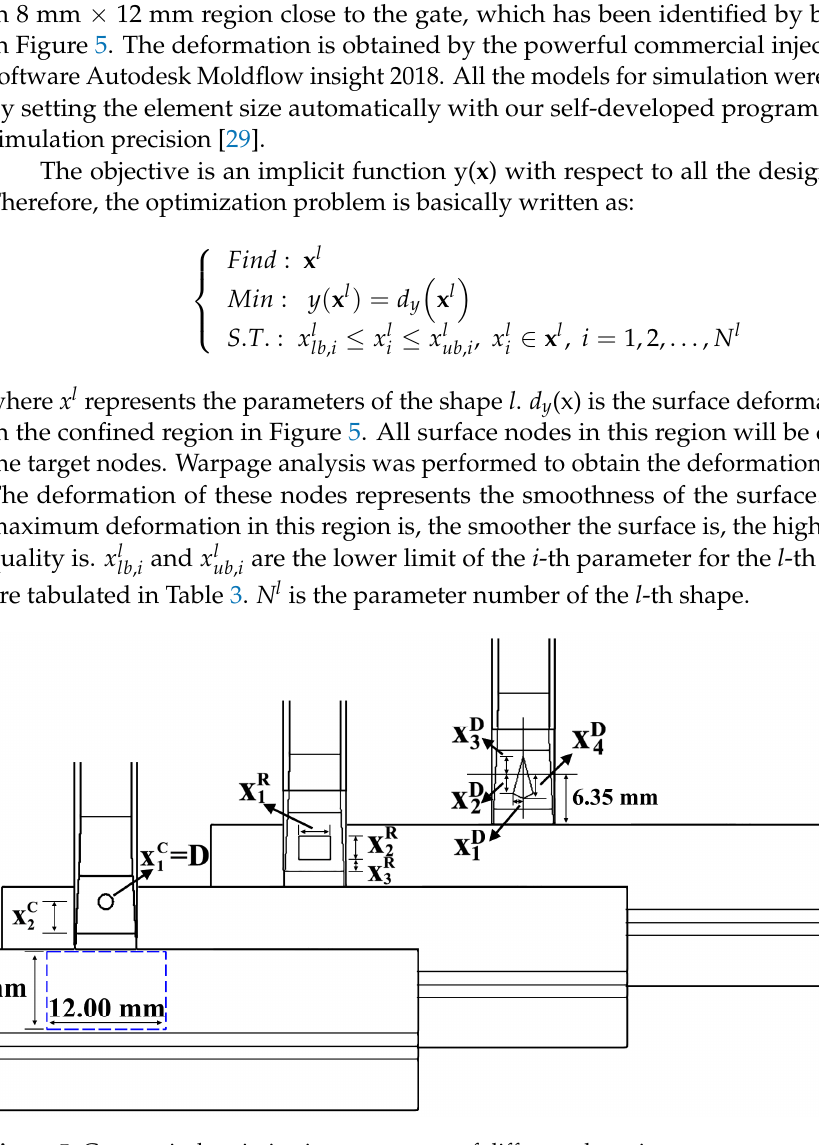
Figure 5. Geometrical optimization parameters of different shape inserts.